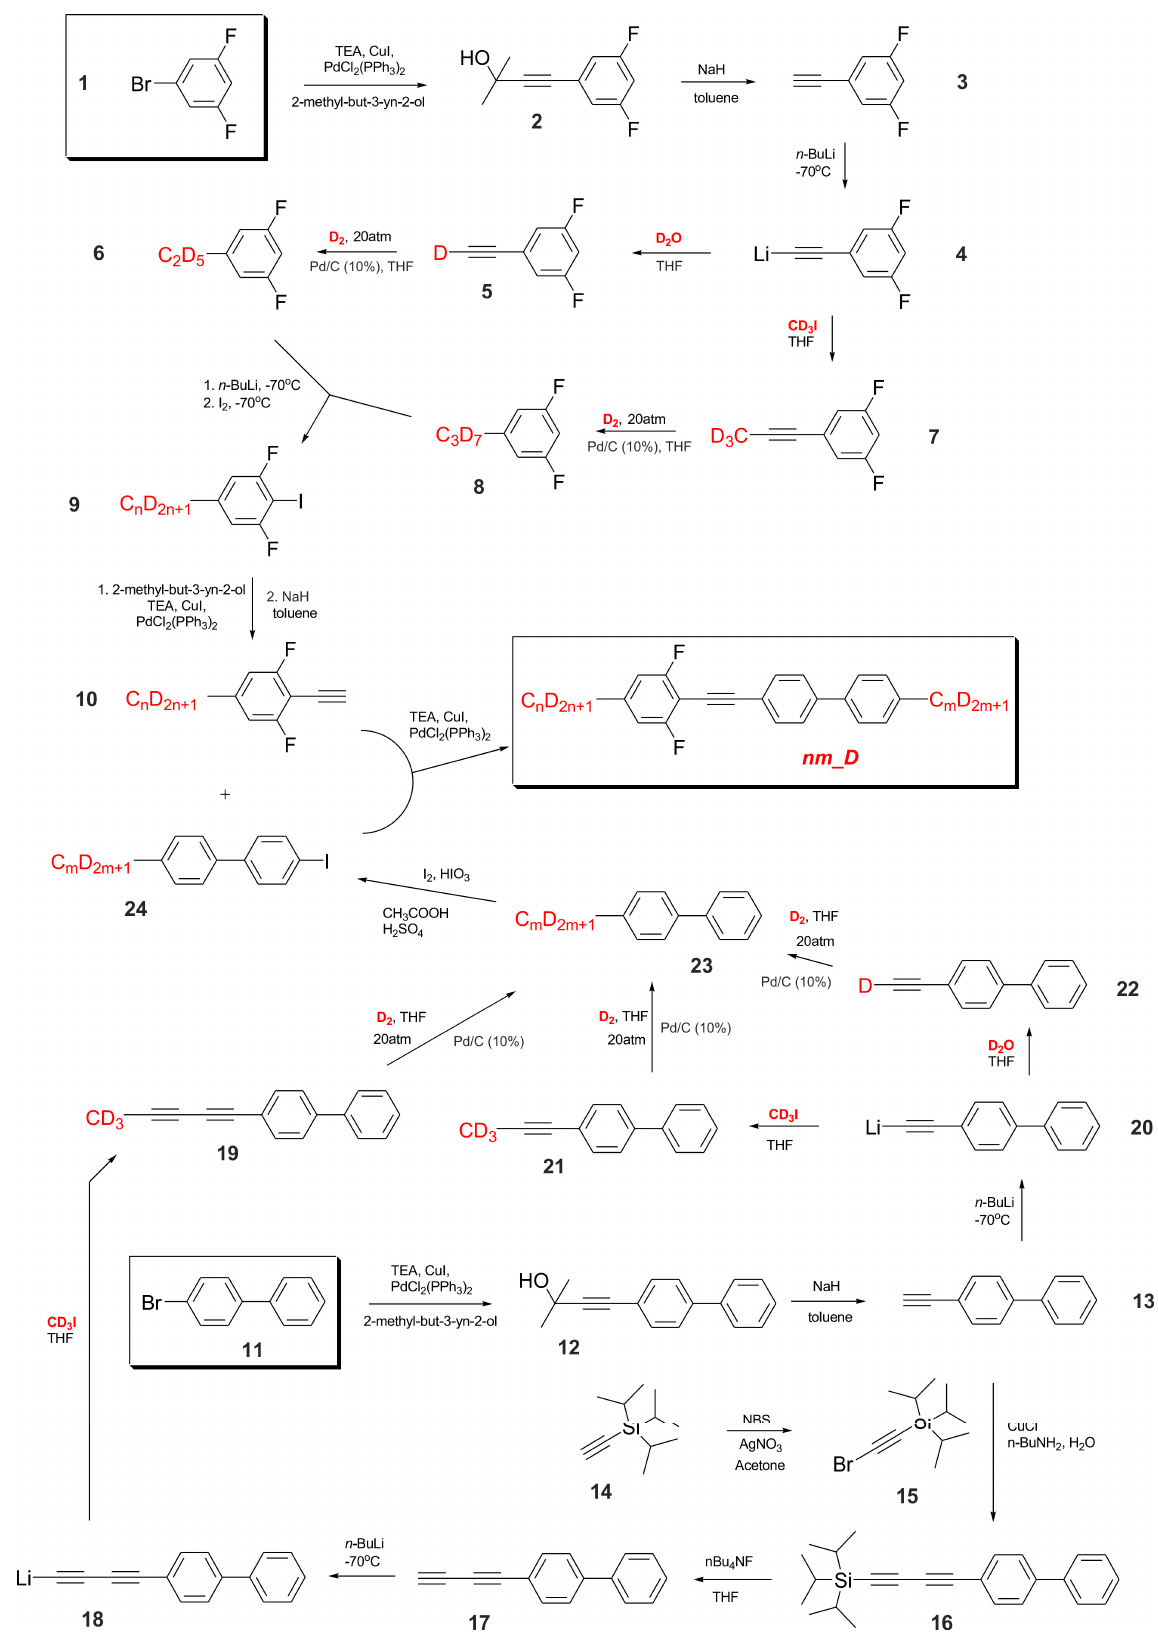
Figure 2. Synthesis of alkyl-deuterated tolanes nm_D .